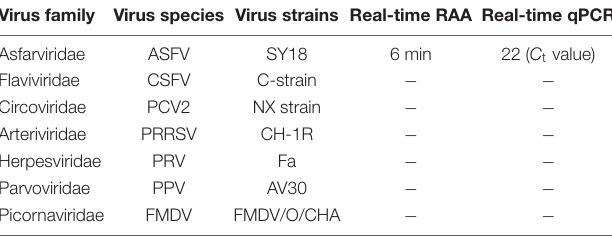
TABLE 2 | Evaluation of the specificity of the real-time recombinase-aid amplification (RAA) assay. Virus family Virus species Virus strains Real-time RAA Real-time qPCR Asfarviridae